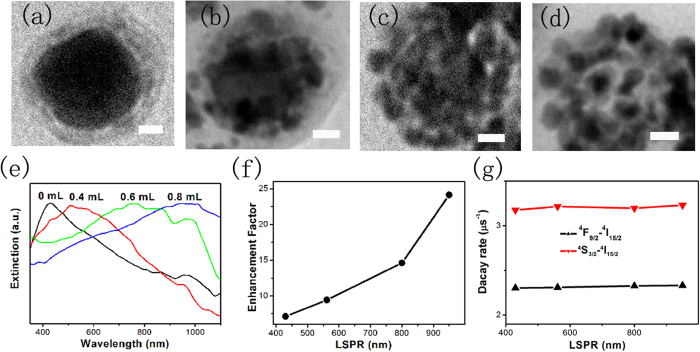
(a–d) TEM images of Ag nanocube@7.5 nm NaYF4@NaYF4:Yb,Er after the galvanic replacement reaction with different volumes (0, 0.4, 0.6, 0.8 mL) of 0.3 mM HAuCl4 solution. (e) Extinction spectra corresponding to the TEM images of (a–d). (f) EF of Au-Ag nanocage@7.5 nm NaYF4@NaYF4:Yb,Er versus the LSPR peaks, related to the Ag nanocube@7.5 nm NaYF4@NaYF4:Yb,Er. (g) Decay rates of 4S3/2-4I15/2 and 4F9/2-4I15/2 as a function of the LSPR locations. All of scale bar: 10 nm.